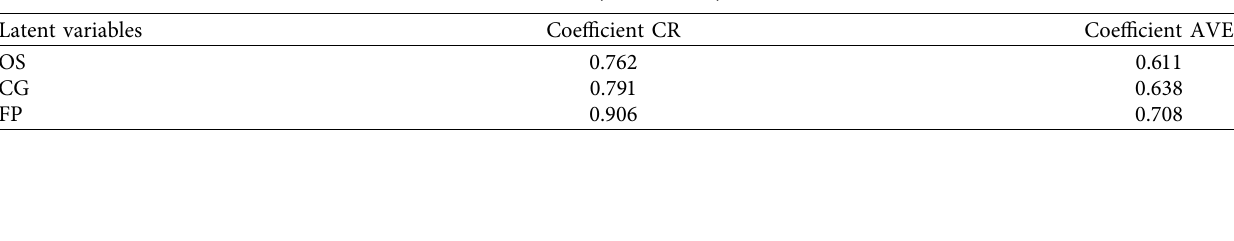
Table 6: Results of reliability and validity of the